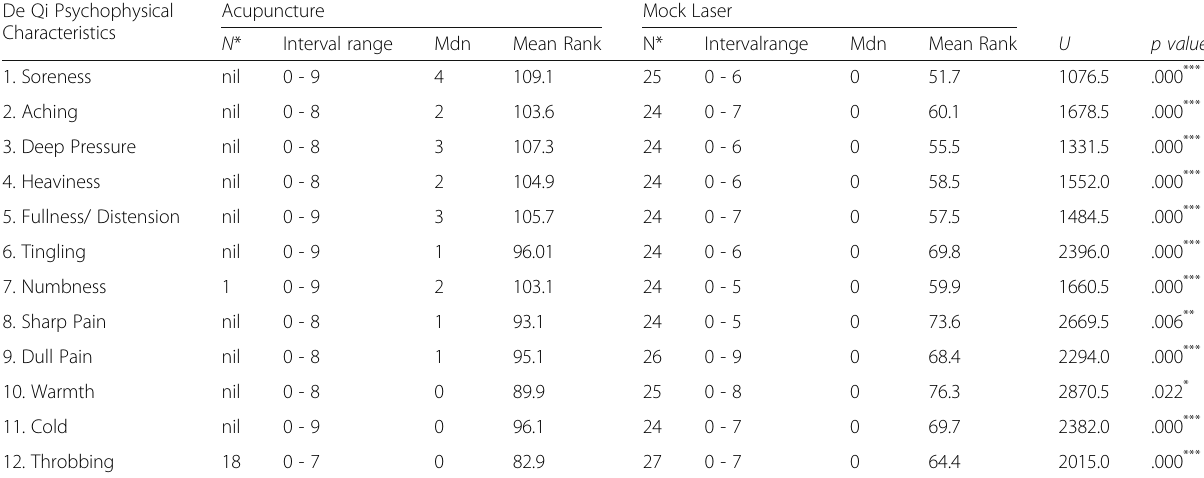
Table 4 Comparison of the intensity of individual De Qi characteristics between the study groups De Qi Psychophysical Characteristics